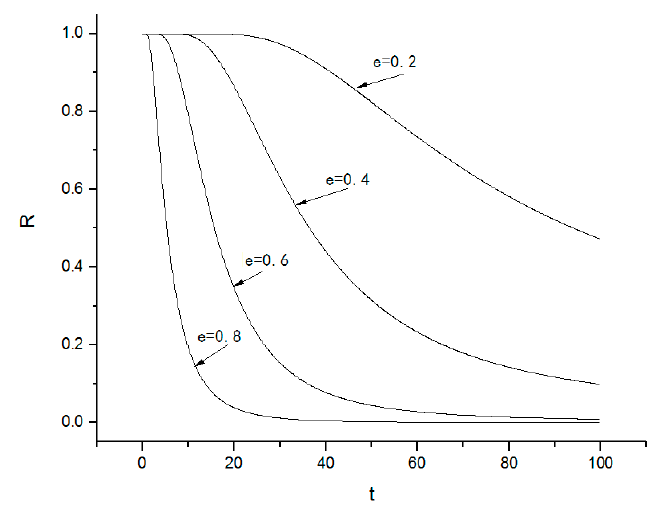
Figure 8. System reliability.